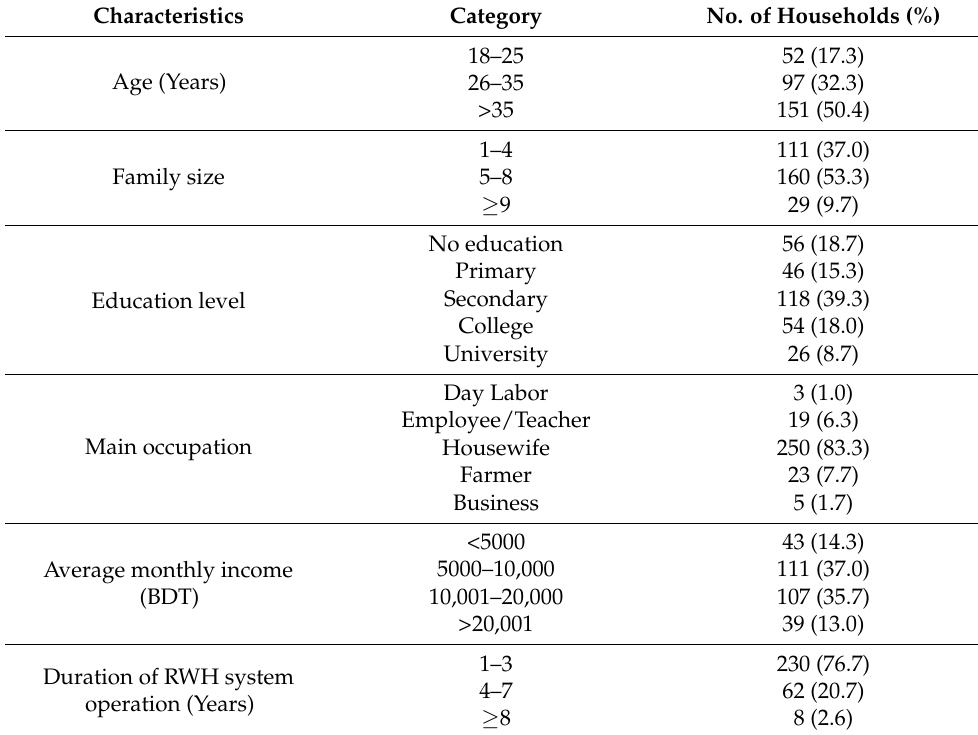
Table 1. Socio-demographic characteristics of the surveyed